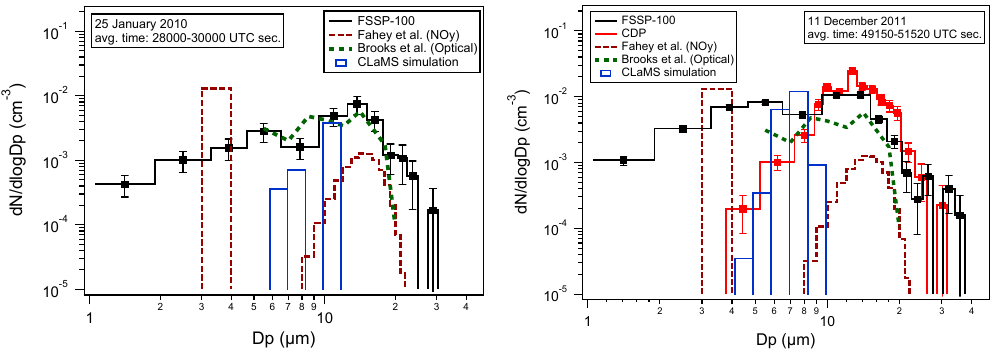
Figure 12. Size distributions of large HNO 3 -containing PSC particles with the highest number densities from the 2010 and 2011 campaigns. The RECONCILE flight on 25 January 2010 is shown in the left panel, and the ESSenCe flight on 11 December 2011 in the right, where the number density and particle volume is about a factor of 2 higher compared with the largest values from RECONCILE. CLaMS model simu- lations (blue) for the corresponding coordinates of space and time do not reproduce NAT particle diameters above 12µm. Both measurements are compared to similar findings in Fahey et al. (2001) (retrieved from total NO y ) and Brooks et al. (2003) (optical measurements).